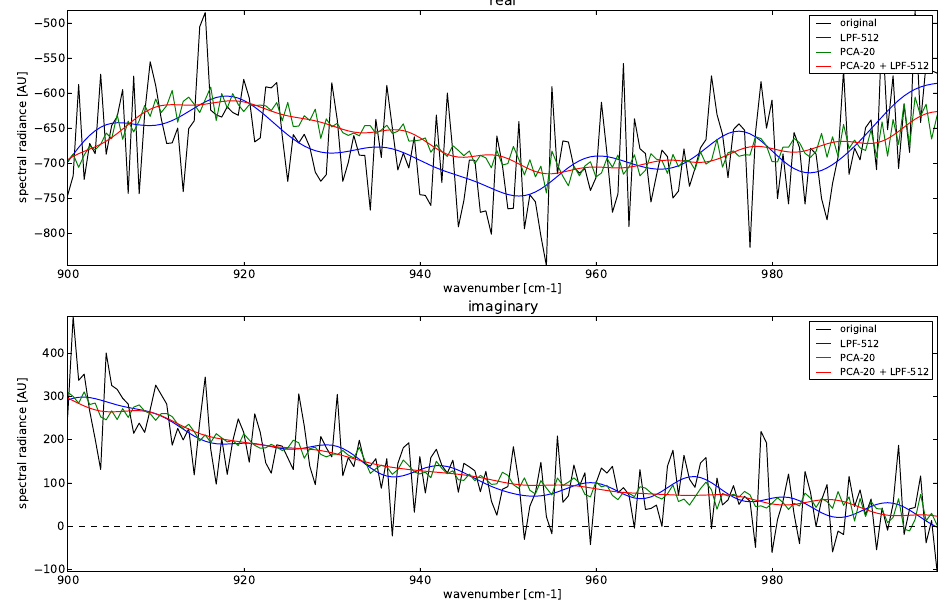
Figure 14. Comparison between the PCA, low-pass and combined noise suppression methods (cf. Fig. 12) in a limited spectral range. Between 920 and 960cm − 1 , a visible difference appears between the PCA methods and the pure LPF method. This difference is still within the original spectrum’s noise range.